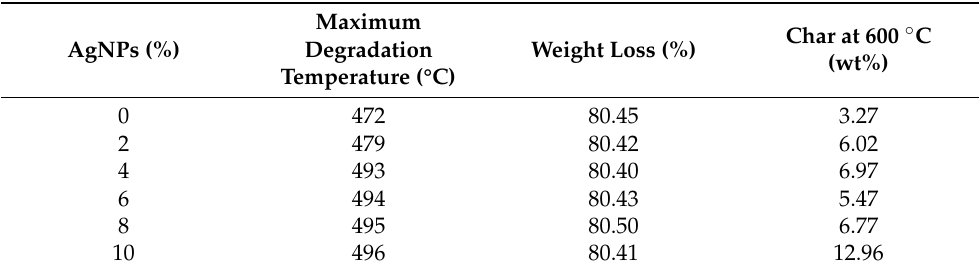
Table 1. The initial and maximum degradation temperature values of the kenaf/HDPE composites from TGA